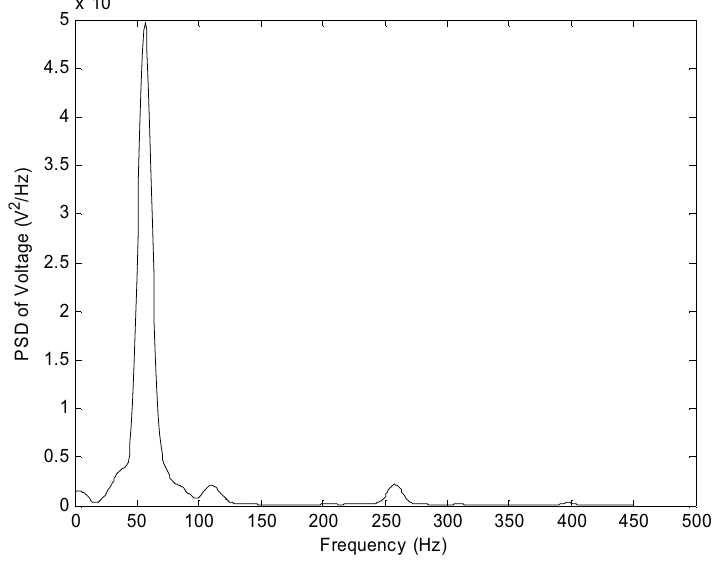
Fig. 8. Frequency spectrum of the PZT sensor voltage of Fig. 7.